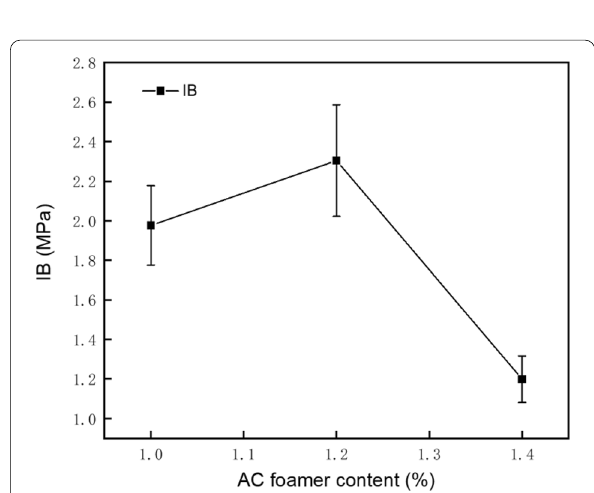
Fig. 7 IB at different AC foaming agents with 12% PF content